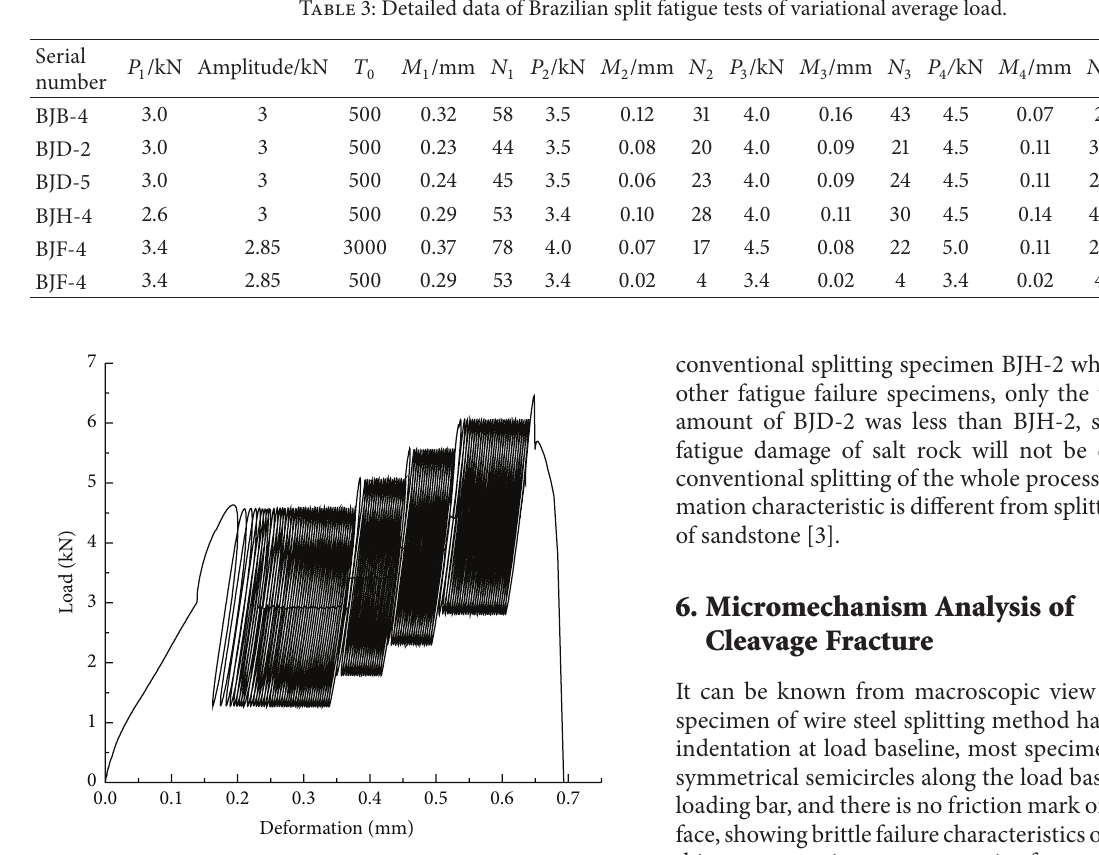
Table 3: Detailed data of Brazilian split fatigue tests of variational average load.